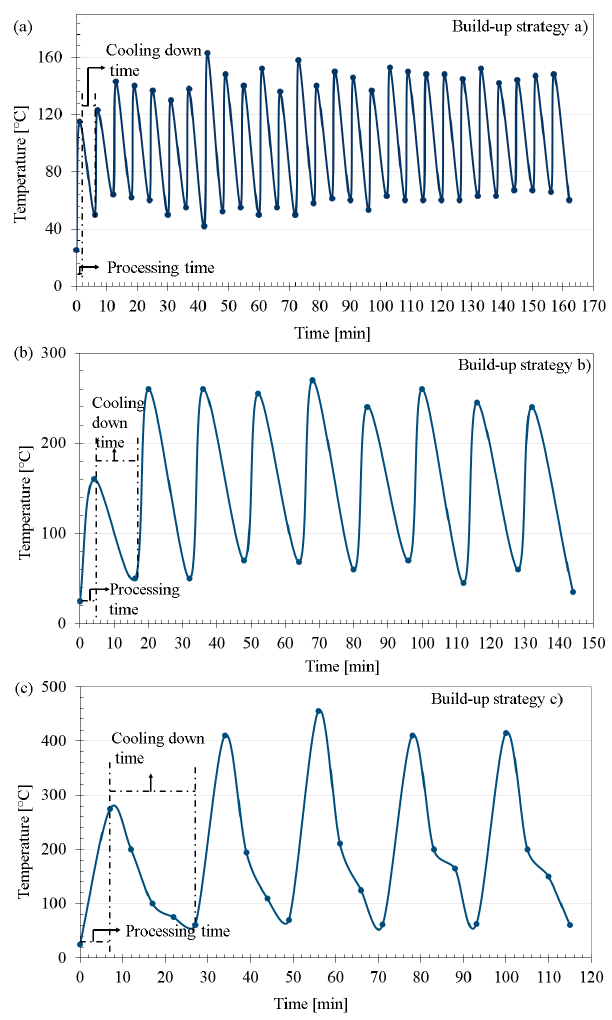
Figure 13. Surface temperature evolution for build-up strategy ( a ) one single layer; ( b ) three consecutive layers; ( c ) five consecutive layers as a